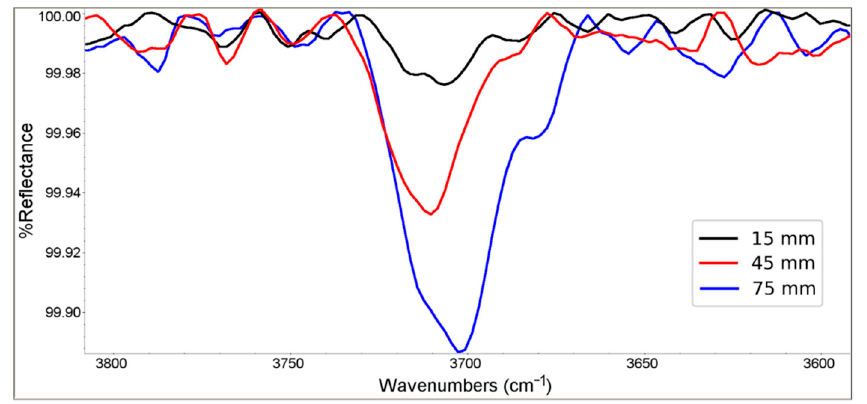
Figure 3. The FTIR grazing angle reflectance spectra registered at different positions (indicated in the legend) along the 80 mm long superhydrophobic substrate S4.